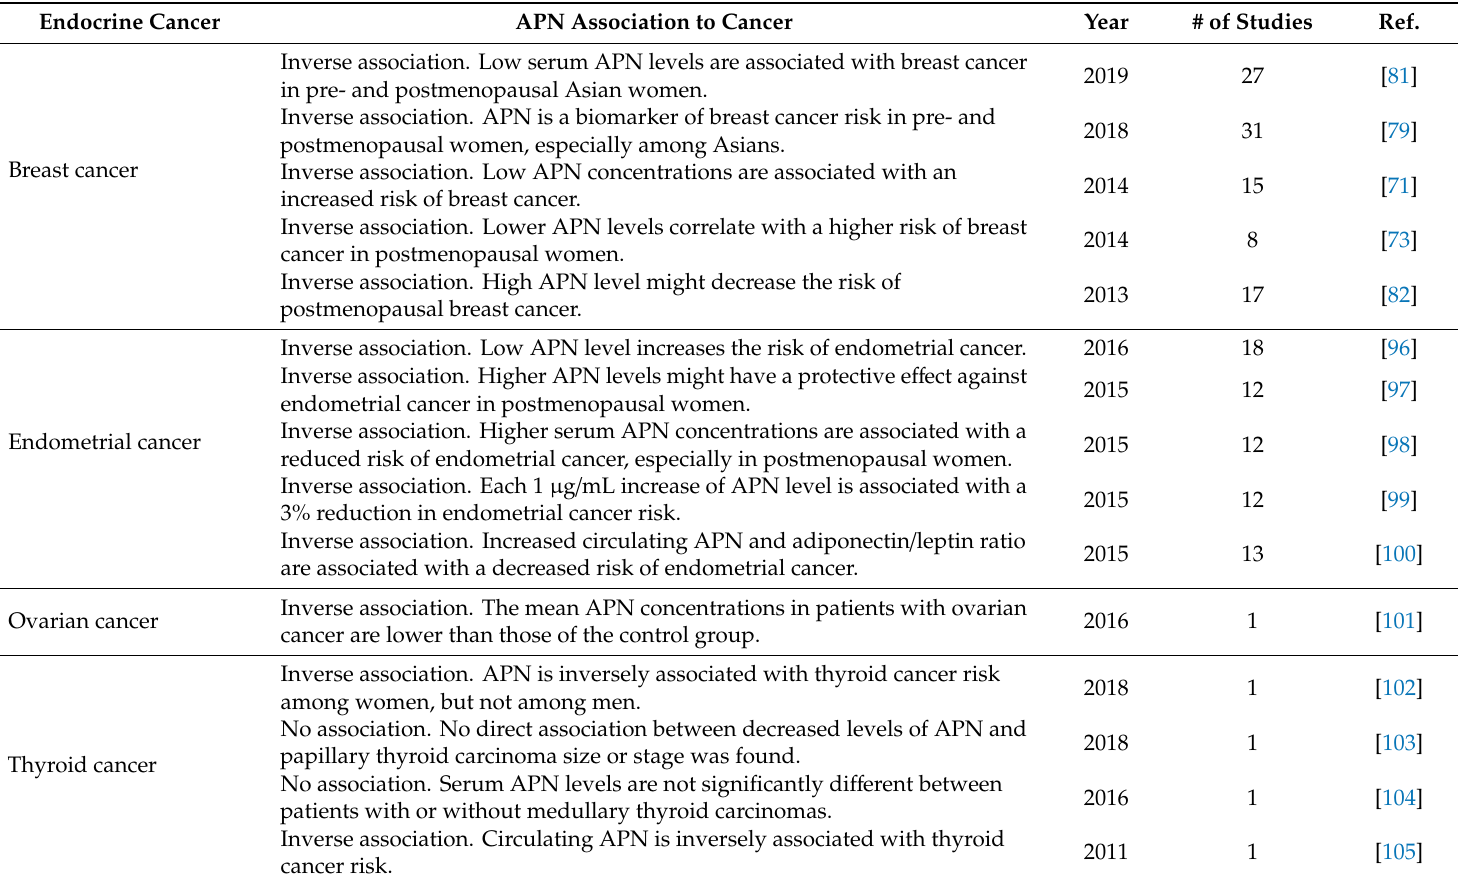
Table 1. Epidemiological associations between APN and endocrine cancers according to available metanalyses or major case–control studies. Endocrine